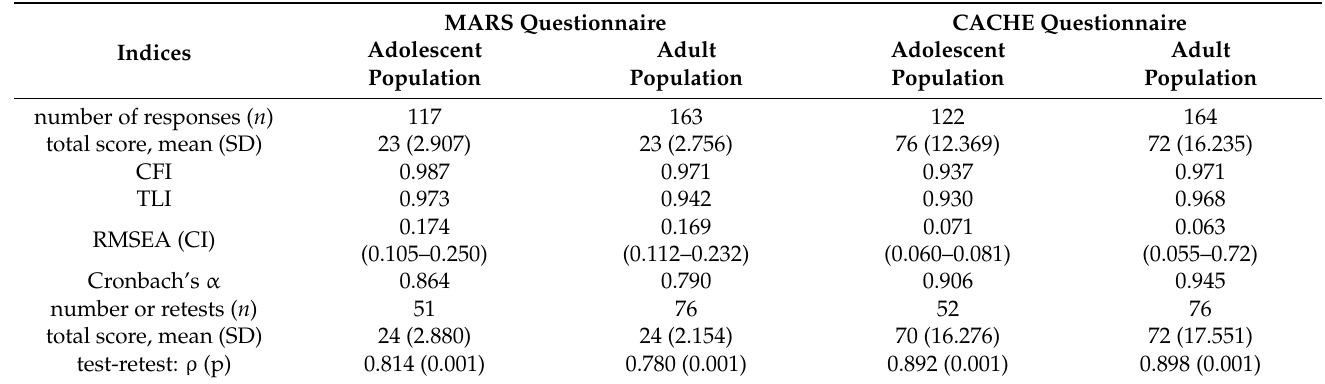
Table 4. Adequacy and reliability indices of the MARS (A) and CACHE (B) questionnaire in the two adaptation groups.